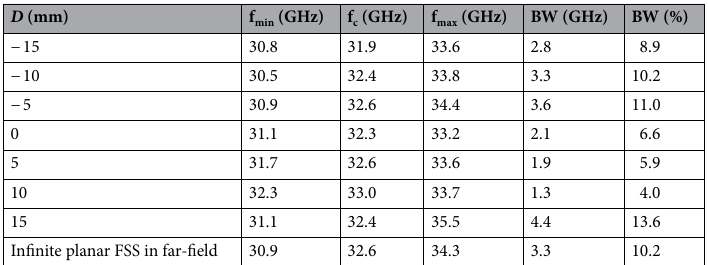
Table 1. Passband parameters of the conformal FSS.